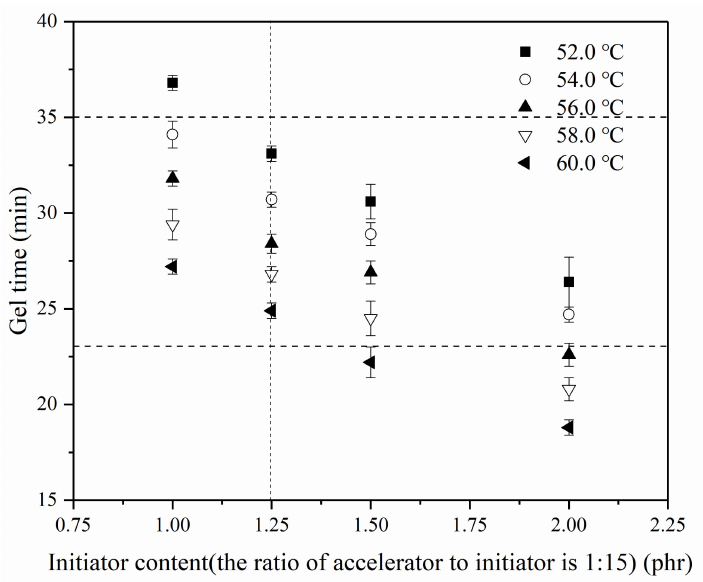
Figure 4. Gel time changes of the resin glue with various contents of initiator and accelerator at a temperature from 52.0 to 60.0 ◦ C.